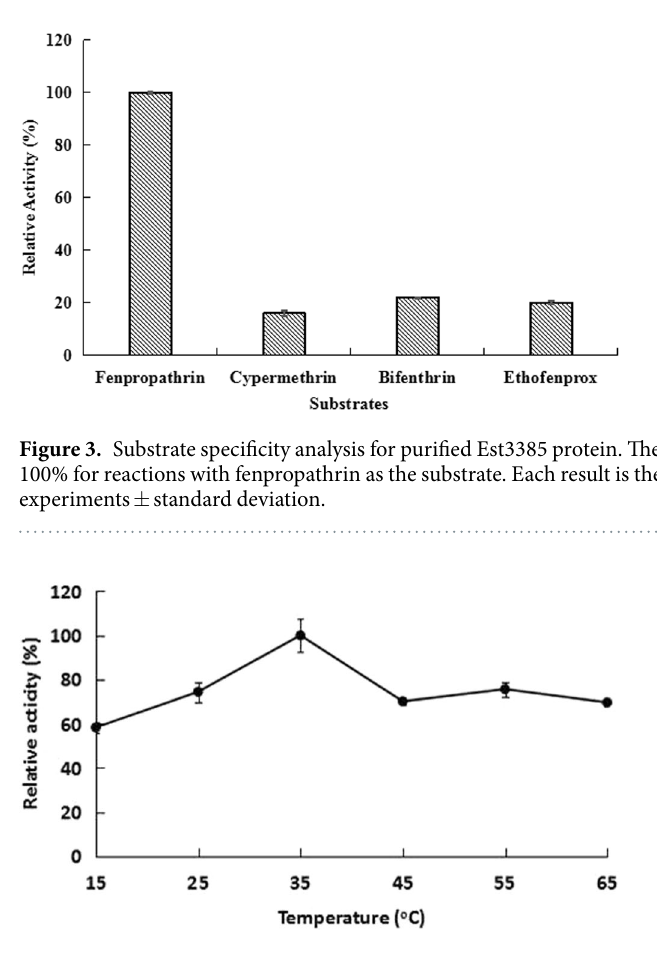
Figure 4. Temperature effect on the activity of purified Est3385 protein. The highest enzyme activity was observed at 35 °C and was set as 100%. Each result is the mean of three independent experiments ± standard deviation.